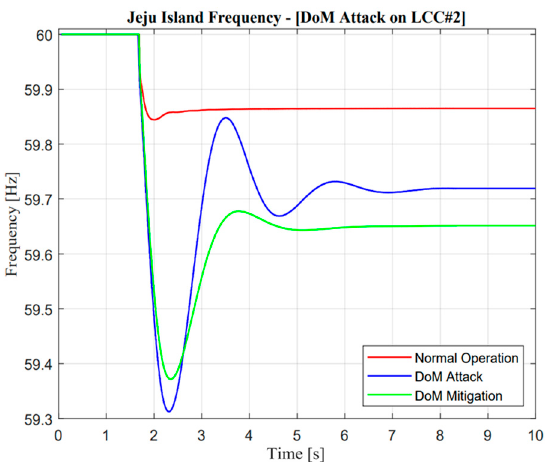
Figure 20. Jeju Island frequency in the delay of measurement attack operation.